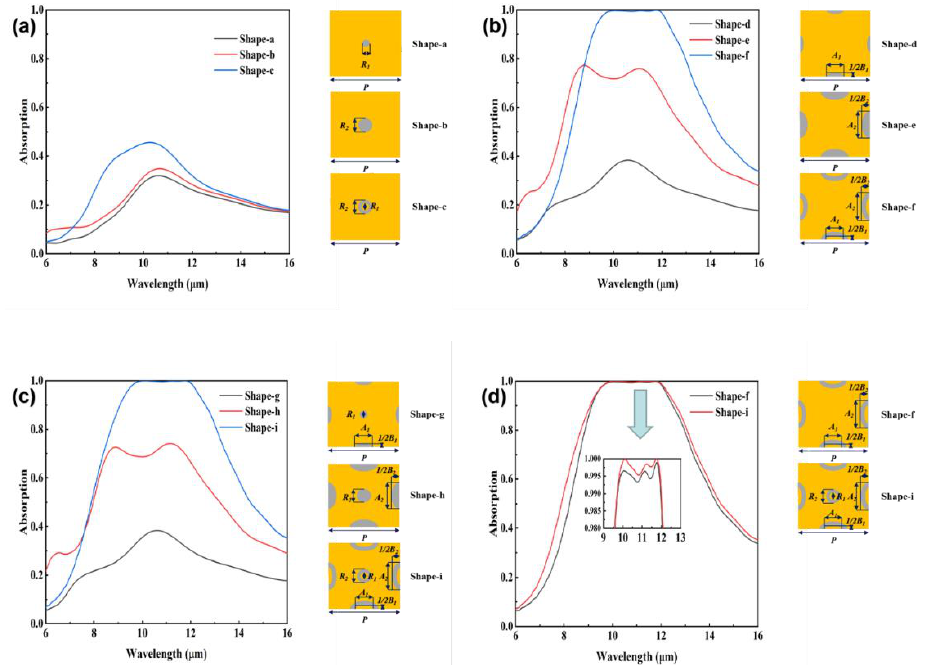
Figure 4. Absorption spectra of different shapes. These shapes are all 20 nm thick and have a period of 2 µ m. ( a ) Circular structure. Shape-a: small circle, R 1 = 220 nm. Shape-b: large circle, R 2 = 400 nm. Shape-a: ring, R 1 = 220 nm, R 2 = 400 nm. ( b ) Elliptical structure. Shape-d: small ellipse, A 1 —500 nm,